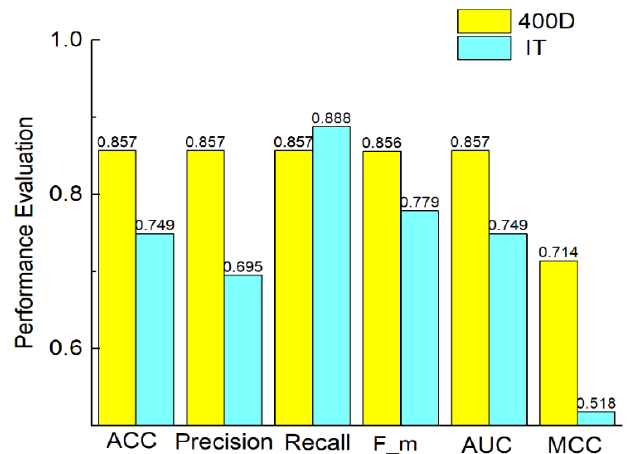
Figure 2. Comparison of 400D with information theory on SVM.